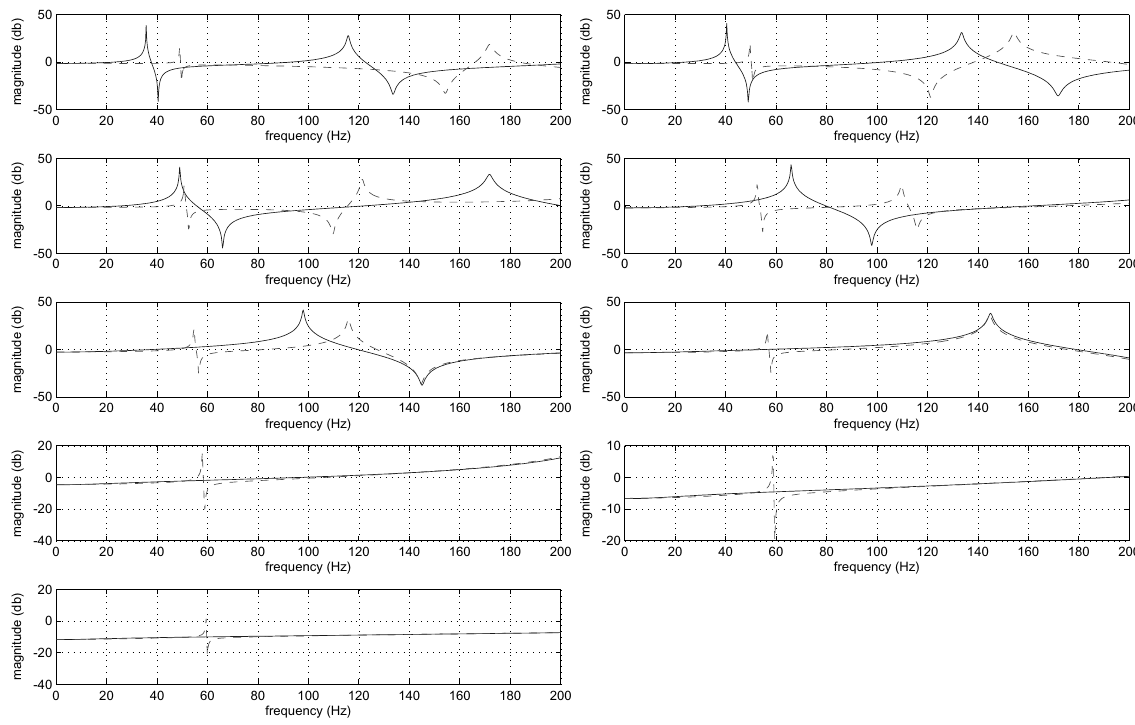
Fig. 8. Transmissibility functions measured on undamaged structure for loading case 1 (full line, force in DOF 1) and loading case 2 (dashed line, force in DOF 2), between responses at DOF 1 and DOF 2 (top left), DOF 2 and DOF 3 (top right) ... DOF 9 and DOF 10 (bottom